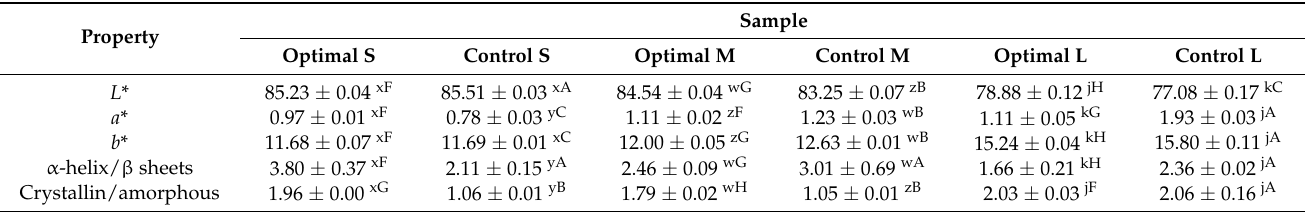
Table 7. Color and molecular characteristics of optimal and control